Question: Looking at the figure, what chart type is it?
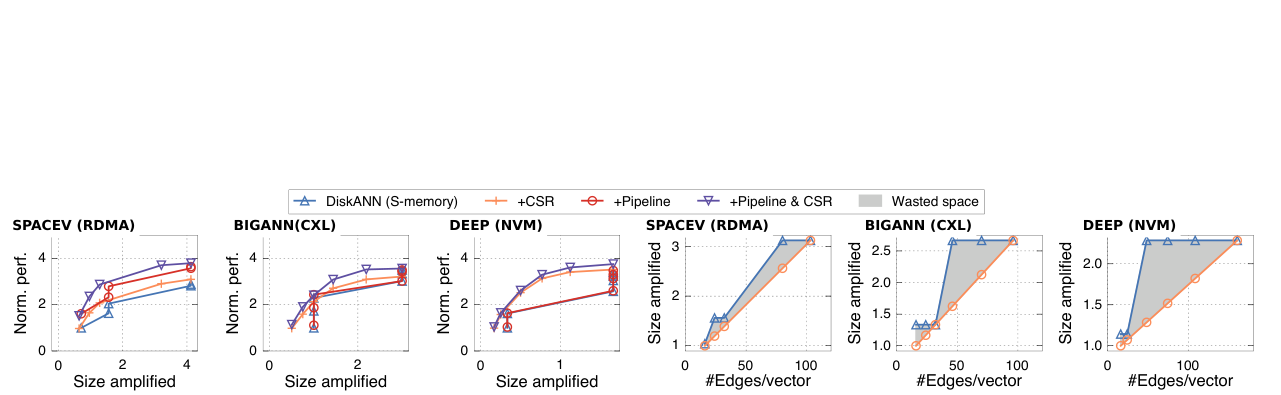
Answer: line